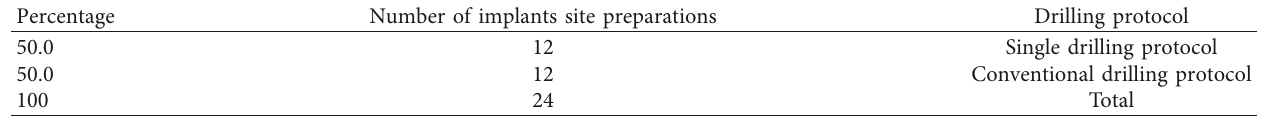
Table 1: The sample distribution according to the method of implant site preparation.